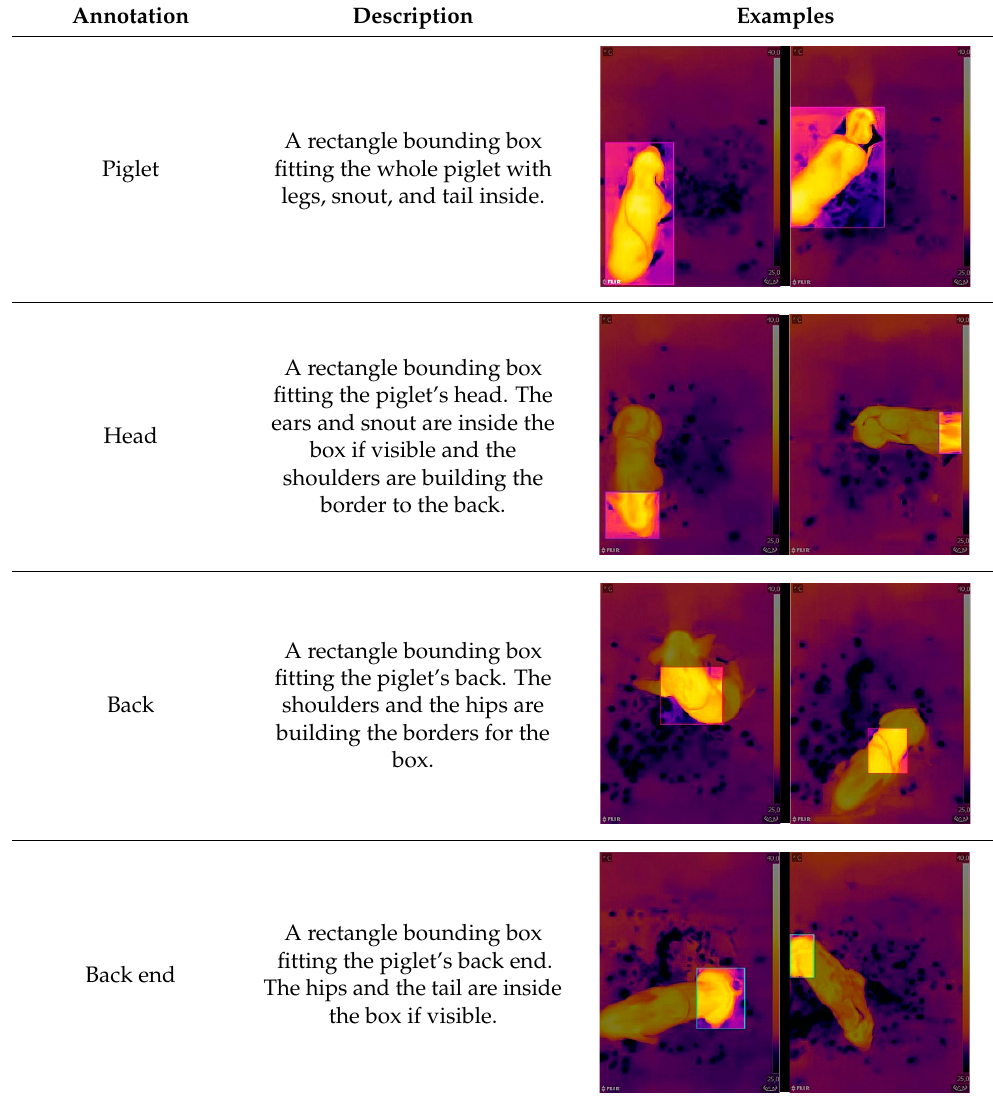
Table 1. Description and example images of body part annotation using bounding boxes with Roboflow annotation tool [32].